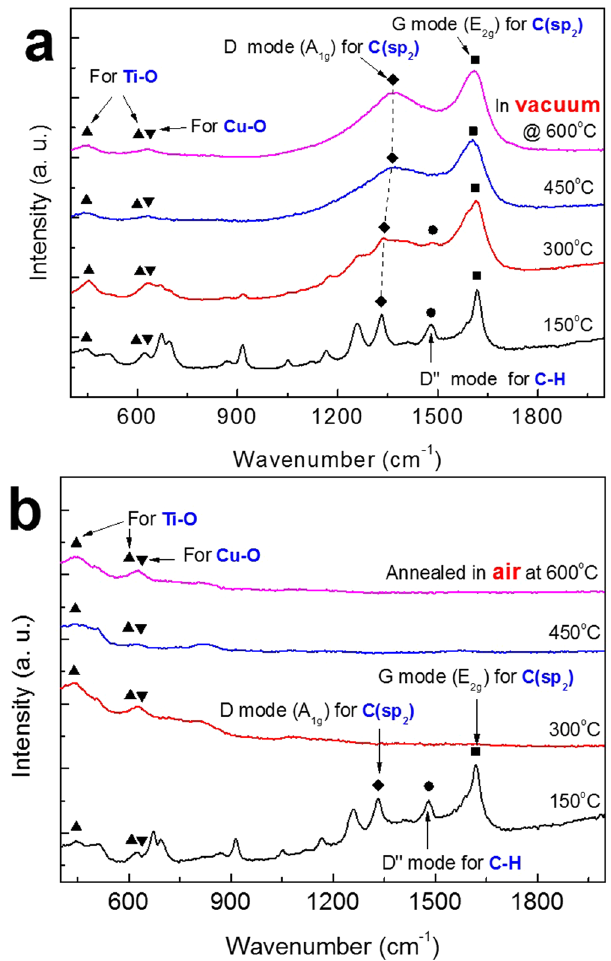
Figure 3. The Raman spectra of the samples with different Temperature in the range 150 to 600 °C ( a ) Vacuum annealing ( b ) Air